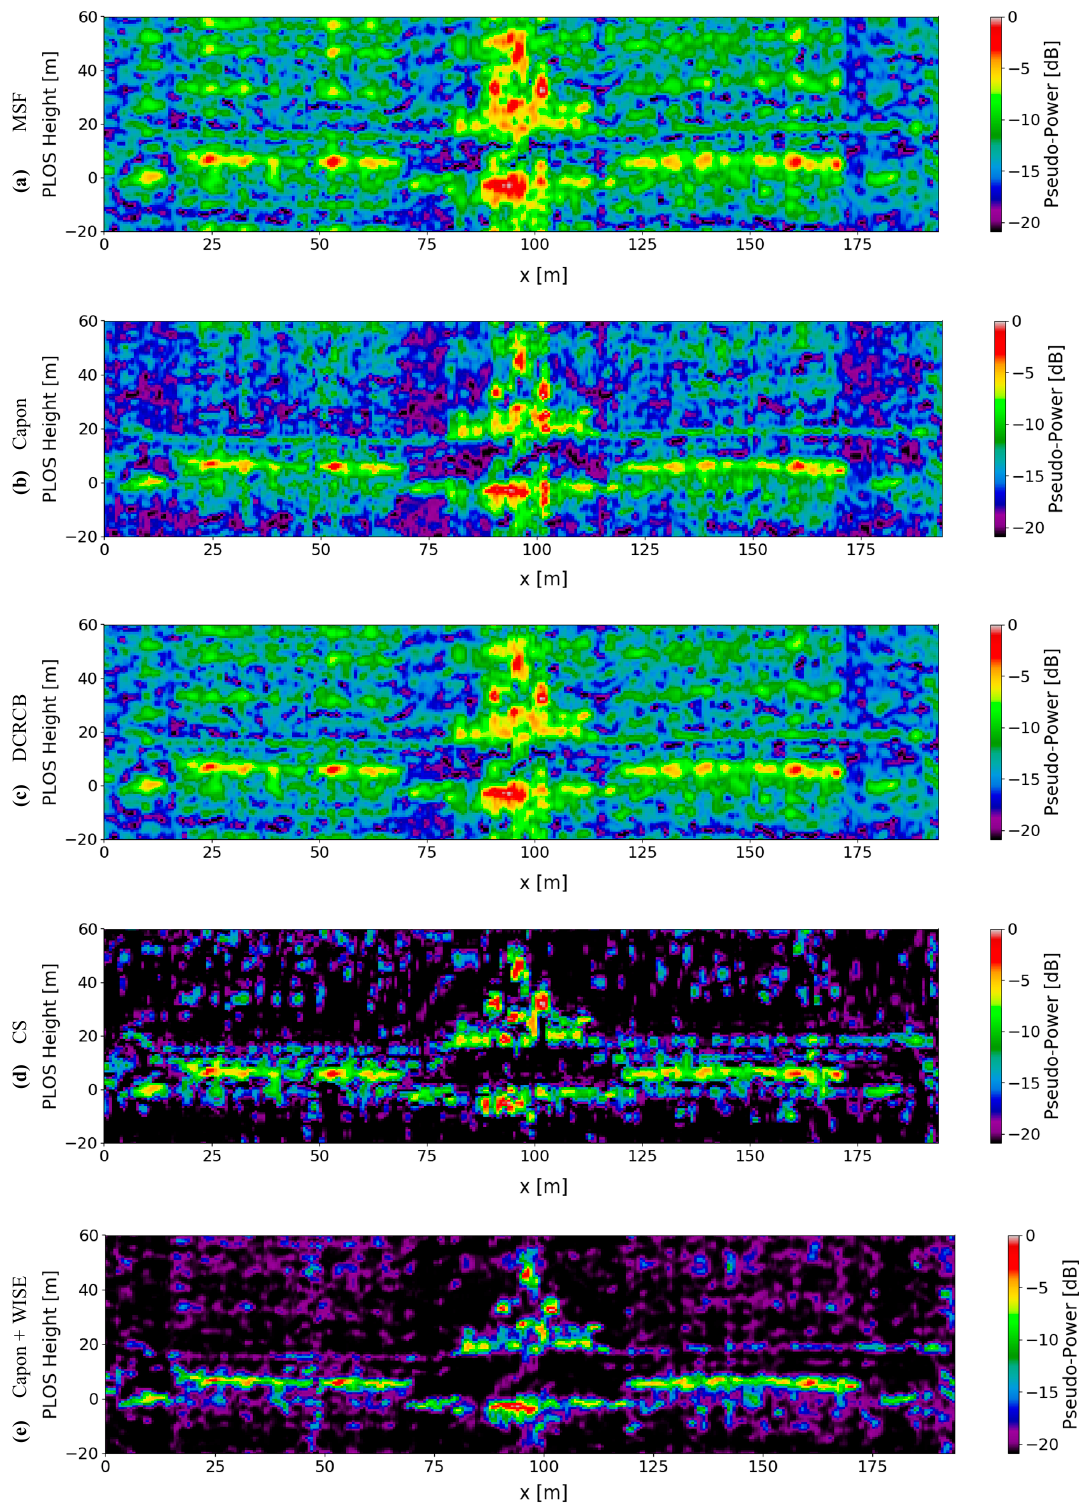
Figure 8. HV tomograms retrieved from the area depicted by the red line crossing the ROI specified in Figure 5. We perform focusing using ( a ) MSF, ( b ) Capon, ( c ) DCRCB, ( d ) CS and ( e ) Capon + WISE. A 15 × 3 (range/azimuth) pixel window is employed to perform multilooking via Boxcar filtering. All tomograms are normalized with respect to the (pseudo) power recovered by MSF.